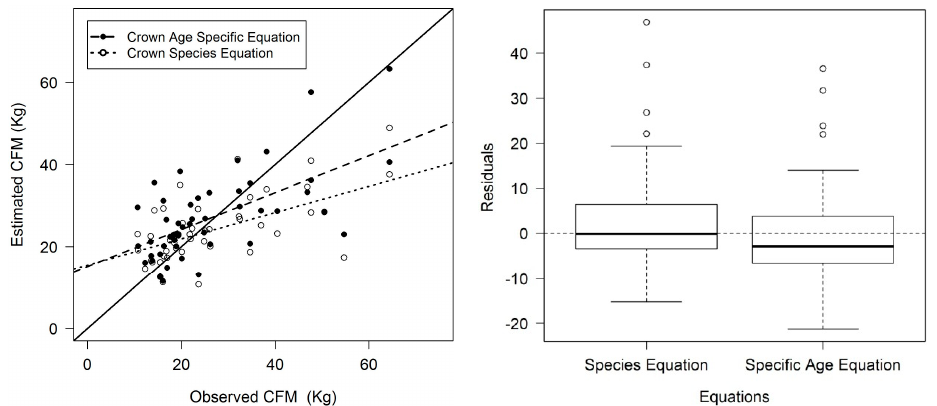
Figure 4. ( Left ) Comparison of allometric equations of crown fresh mass (CFM) using the estimated values by “Crown Species Equation” and “Crown Age Specific Equation” for C 17 in relation to the observed values. ( Right ) Comparing the equations showing the proximity of the means of the residues and the overlap of deviations around the mean between “Crown Species Equation” and “Crown Age Specific Equation” for CFM.